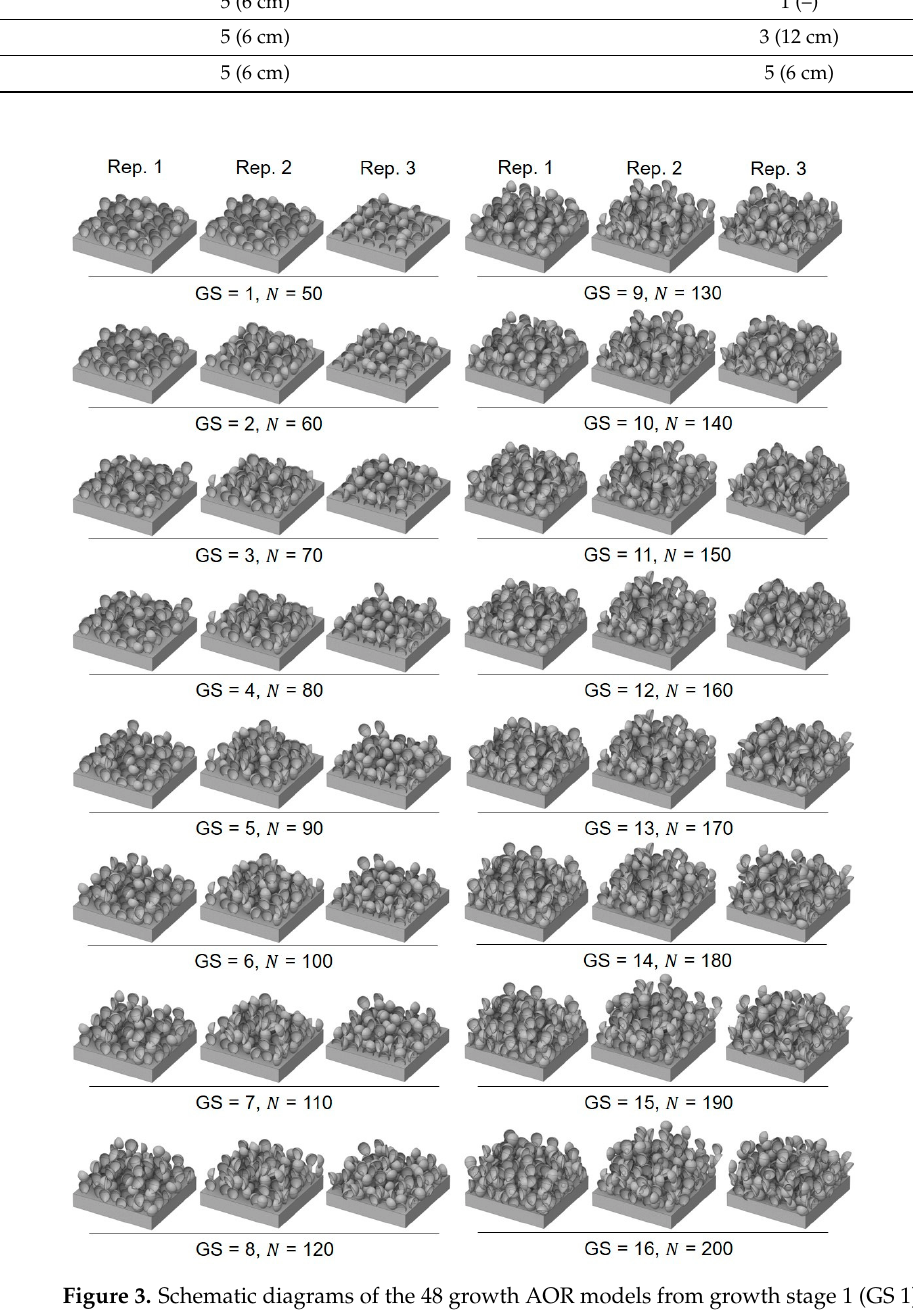
Figure 3. Schematic diagrams of the 48 growth AOR models from growth stage 1 (GS 1) to 16 (GS 16) (not to scale).